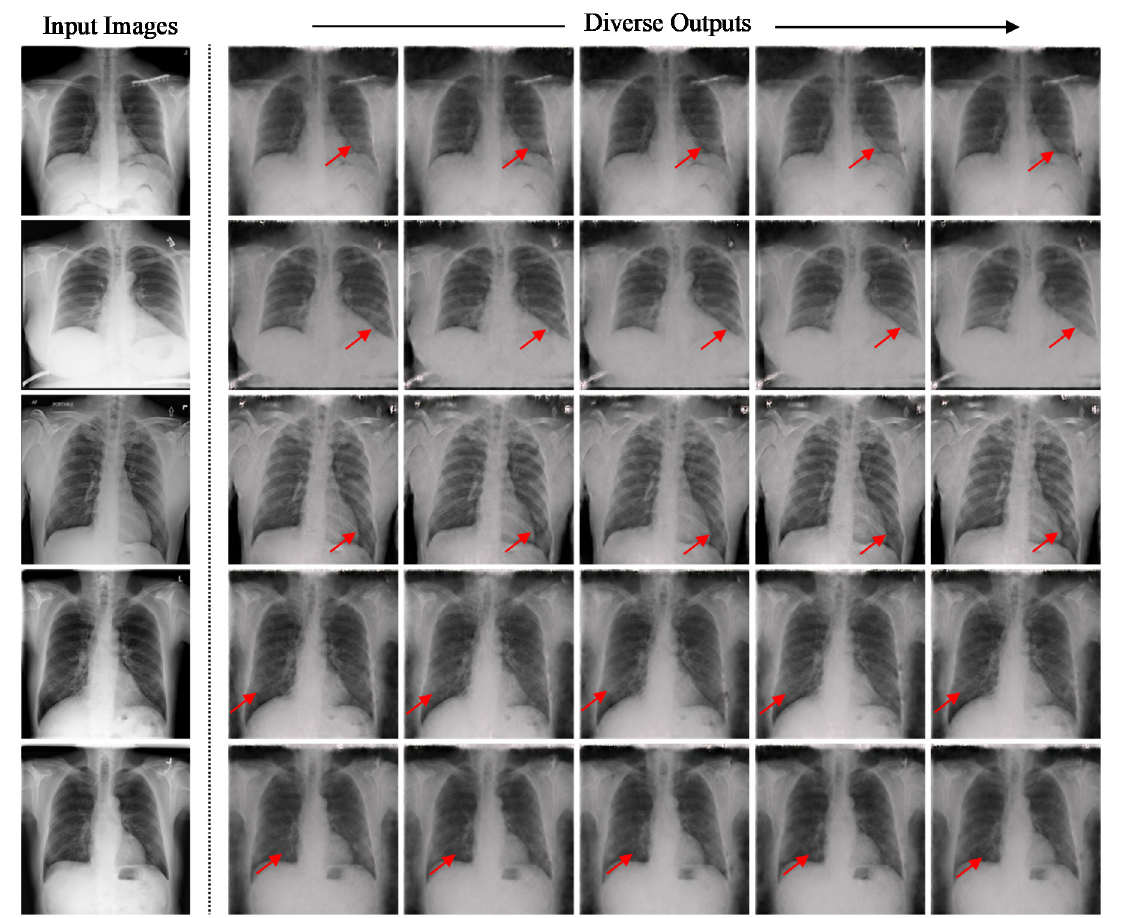
Figure 21. Examples of instance-diverse COVID-19 X-ray images generated from the sRD-GAN framework. The red arrows point to the region where the style attributes generated on the output images are different.